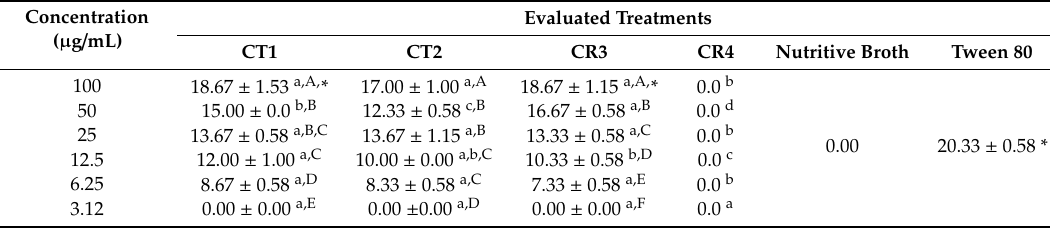
Table 3. Hemolysis halos generated by C. triseriatus and C. ravus venoms.